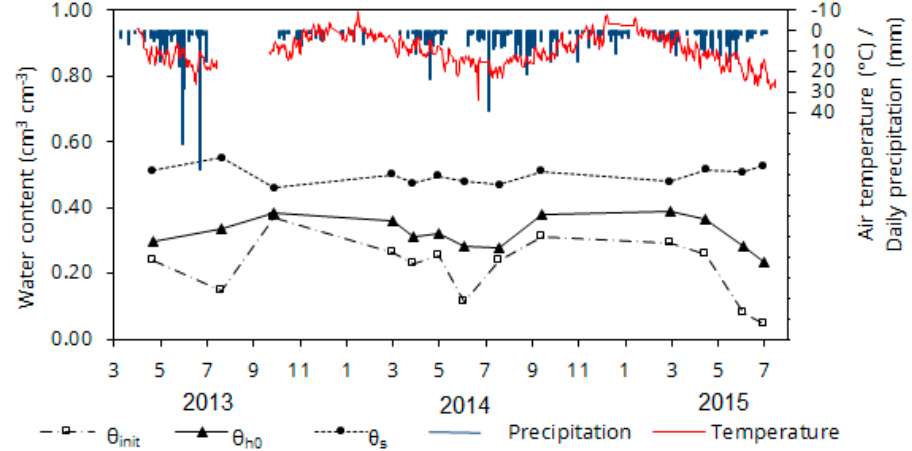
Figure 6. Meteorological and pedological conditions during experiments. Air temperature was measured at a height of 200 cm.